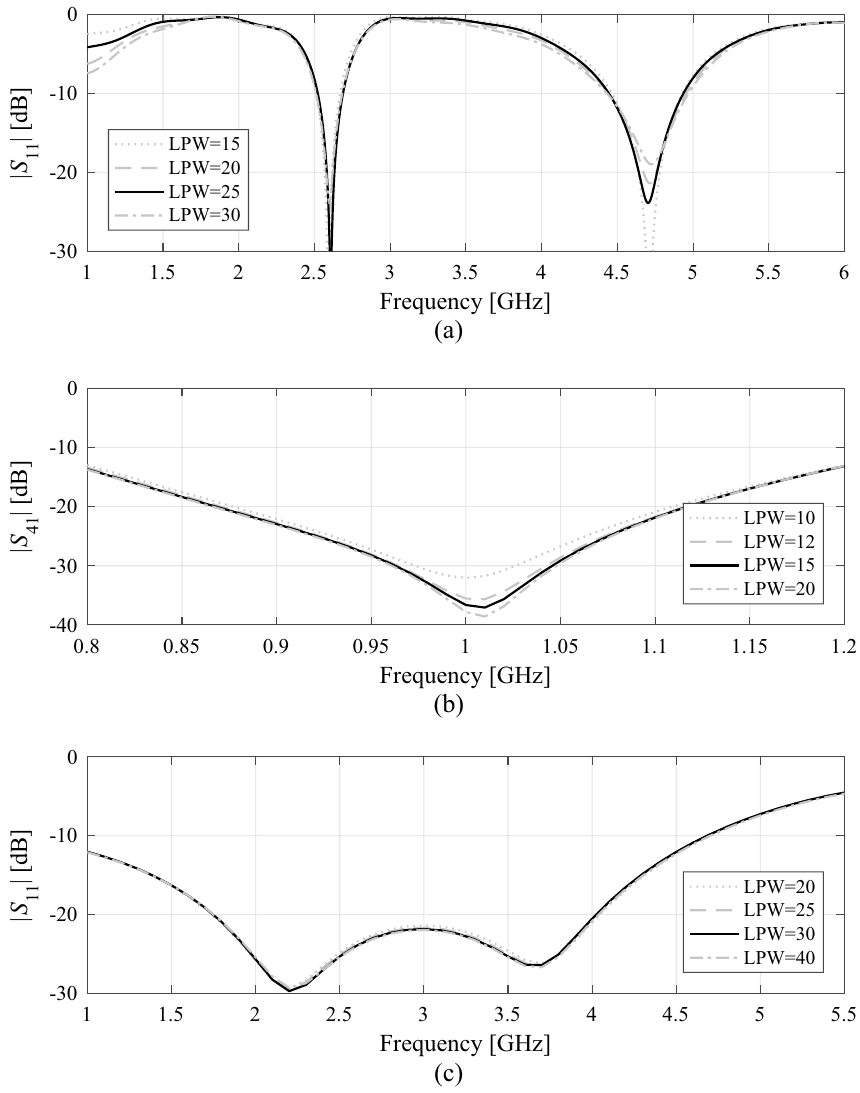
Figure 7. Grid convergence plots for the most representative responses of: ( a ) Structure I, ( b ) Structure II, and ( c ) Structure III for various values of LPW (lines per wavelength) parameter controlling the mesh density in CST Microwave Studio. Black lines pertain to the LPW values used in numerical experiments: 25, 15, and 30 for Structures I through III,